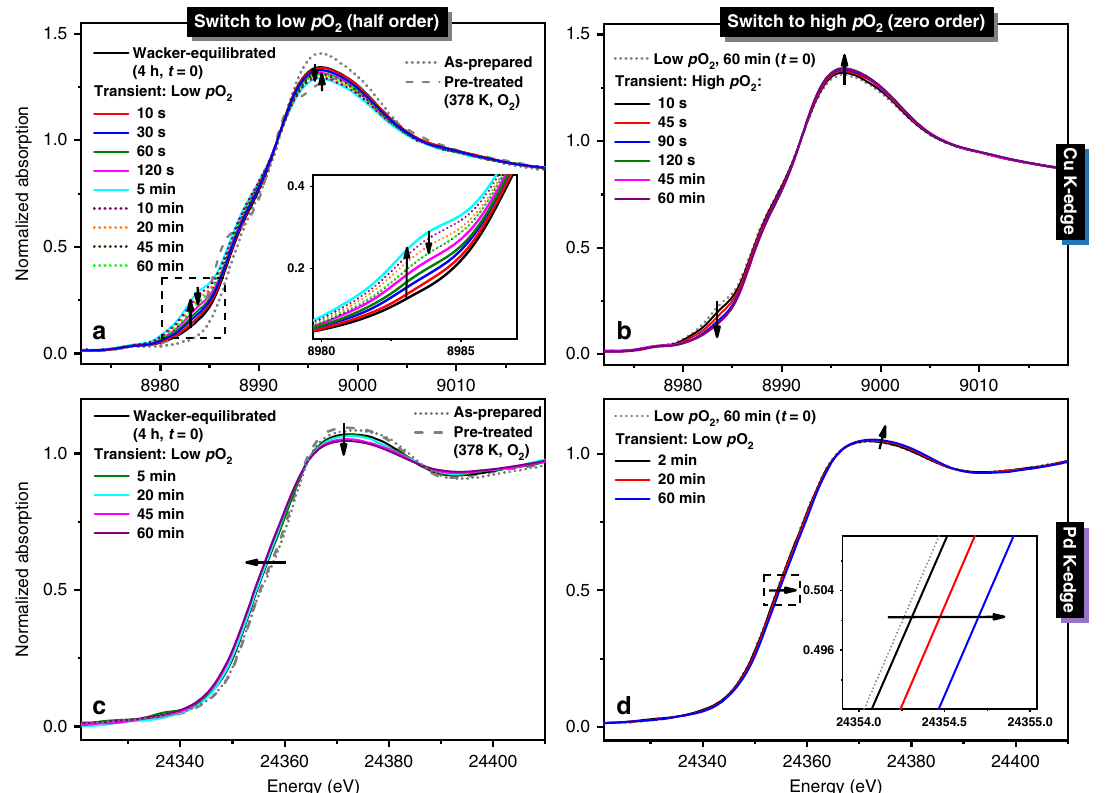
Fig. 2 Time-resolved Cu and Pd K-edge XANES spectra. Normalized time-resolved a , b Cu and c , d Pd K-edge XANES spectra of Pd1Cu5-Y before (as- prepared, pre-treated, Wacker-equilibrated) and during transient experiments with a , c low p O 2 and b , d high p O 2 . Inset: magni fi cation of the a minor peak at 8983 eV corresponding to Cu(I) formation and d shift in absorption edge energy at half-height. Gas feed composition (C 2 H 4 :H 2 O:O 2 ) at high p O 2 (1:7:10) and low p O 2 (1:7:0.05) was balanced with helium to achieve a constant contact time in all experiments.